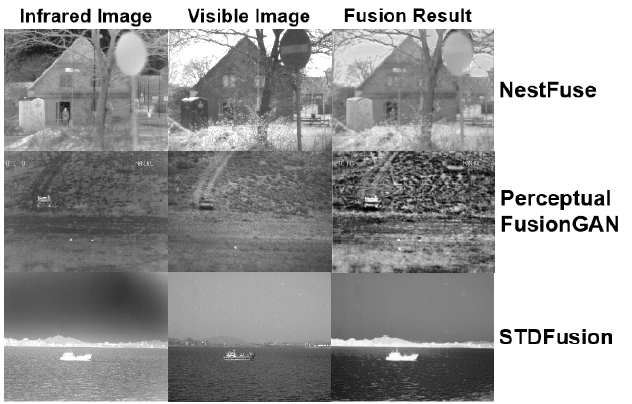
Figure 1. Visualized results of some existing fusion methods in typical